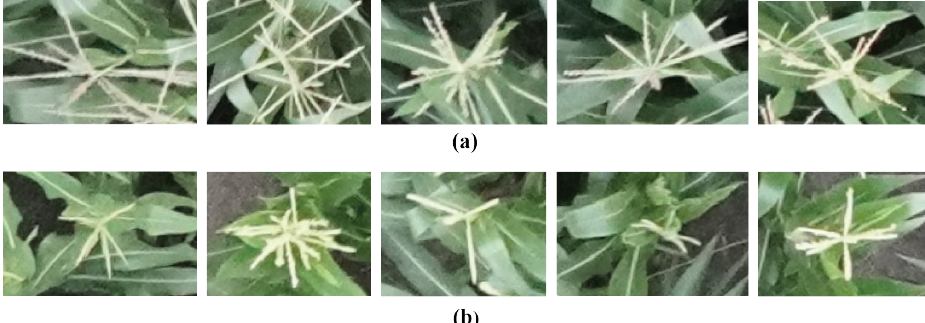
Figure 12. Tassels at different stages of maturity for ( a ) hybrid varieties and ( b ) inbred varieties.